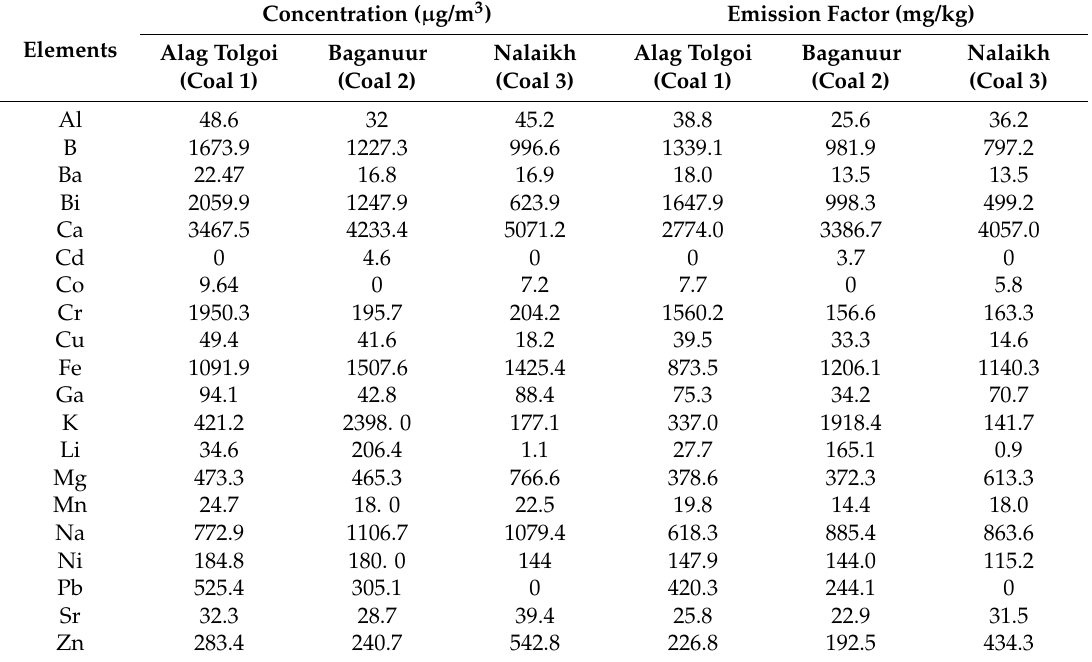
Table 5. Average concentration and emission factor of trace metals released during coal combustion.